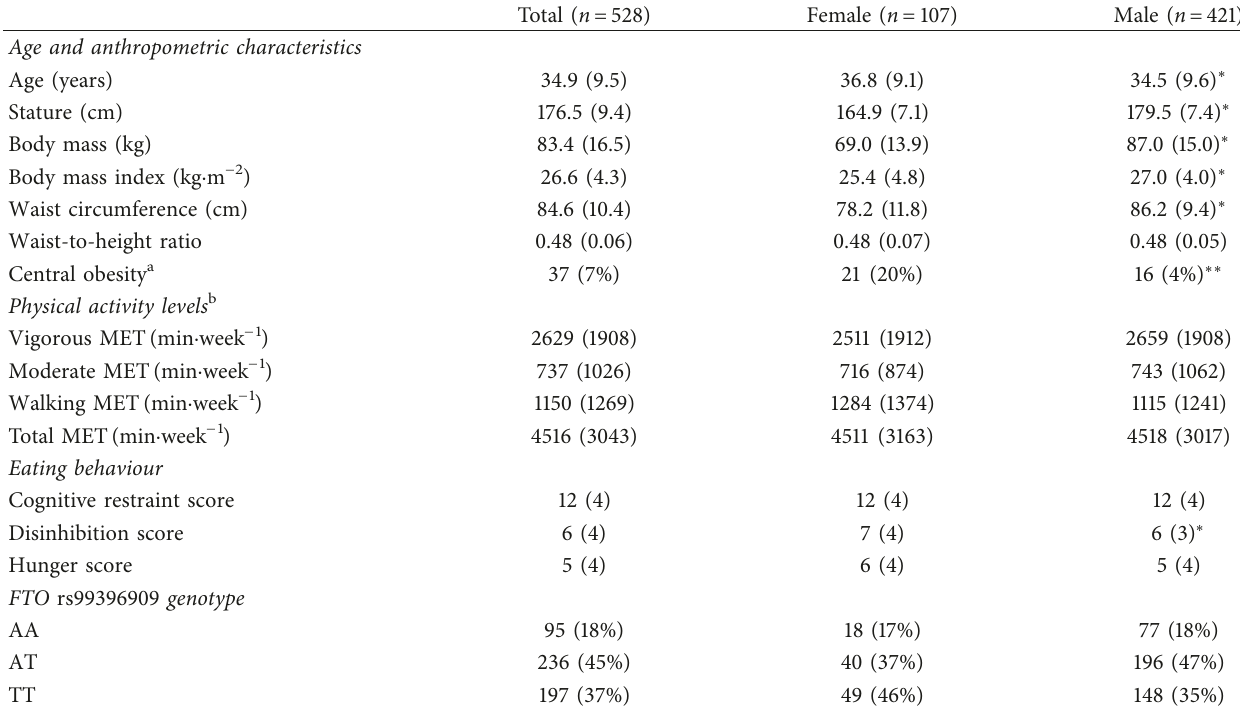
Table 1: Participant